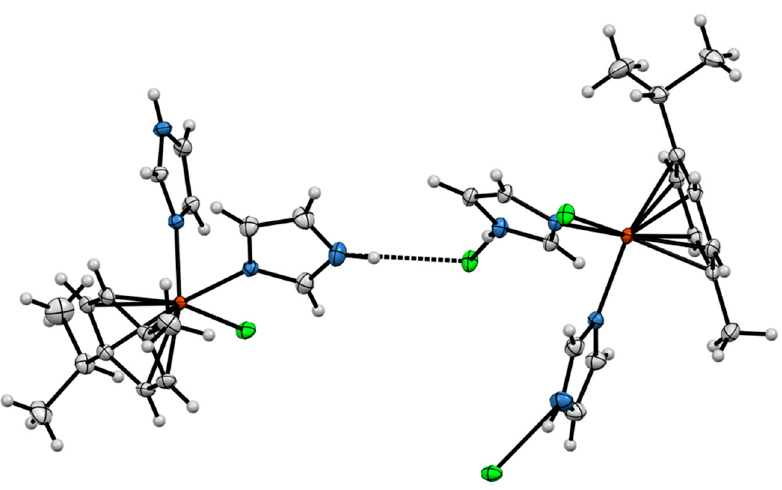
Figure 3. Intermolecular N–H···Cl interactions in the crystal structure of complex 1 .